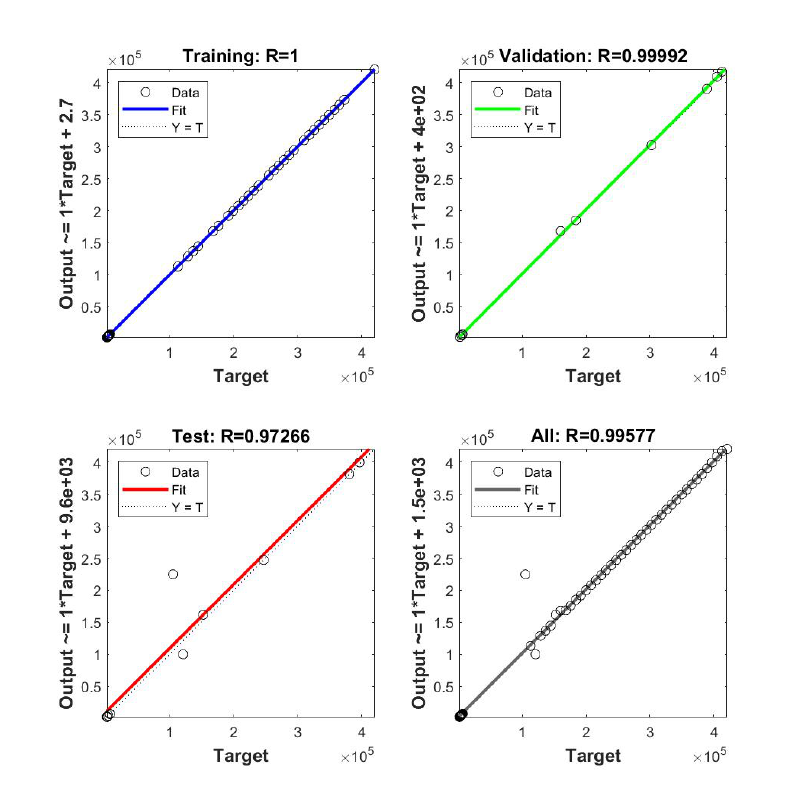
Figure 35. Correlation coefficient R between target data and output data for training, validation and test and mean squared error for the best validation